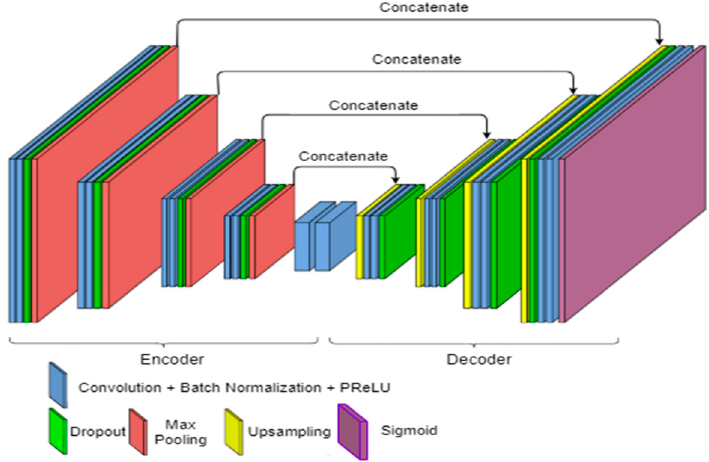
Figure 4. Proposed fully convolutional model for skin-lesion segmentation.